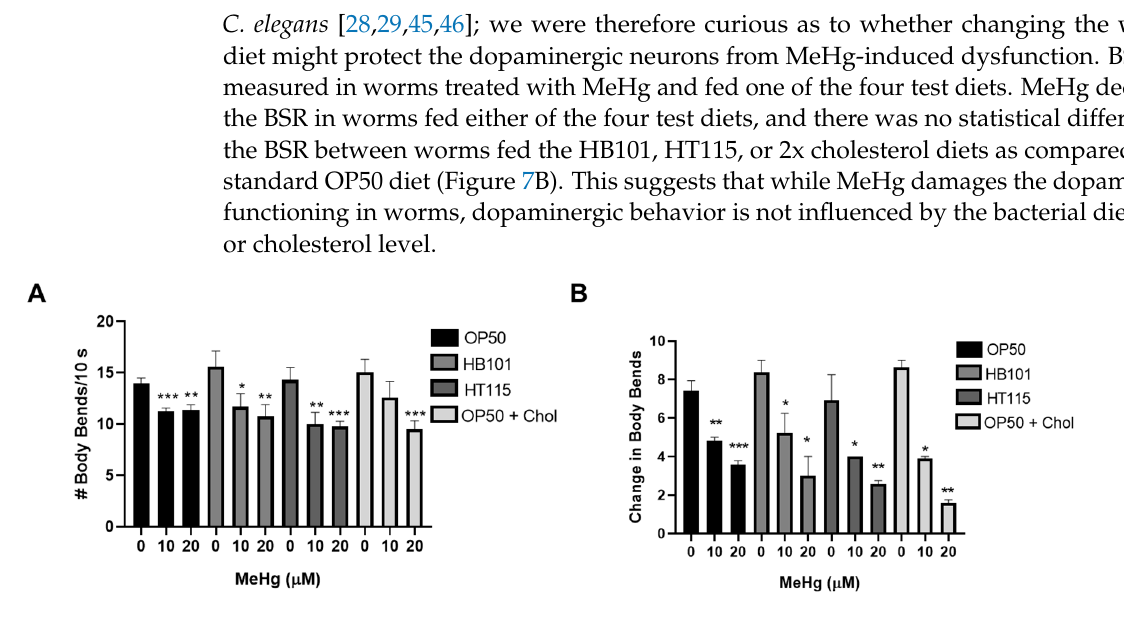
Figure 7. Locomotive and dopaminergic function in response to MeHg are not affected by diet. ( A ) Locomotion behavioral analysis was performed 72 h after MeHg treatment and feeding on the test diets. ( B ) Dopaminergic behavior was assessed by the basal slowing response (BSR) performed 72 h after MeHg treatment and feeding on the test diets. * p < 0.05, ** p < 0.01, *** p < 0.001 as compared with untreated, OP50-fed control.